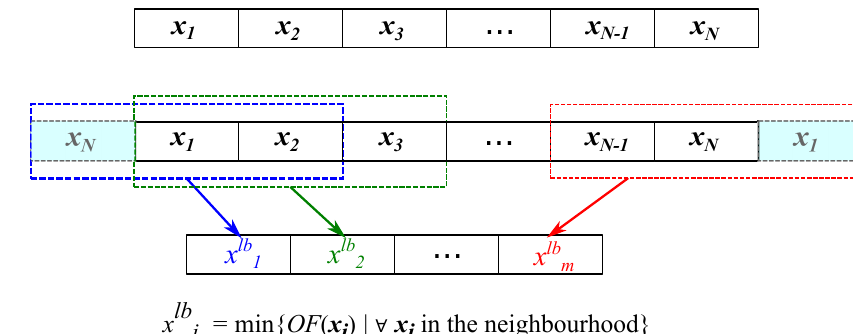
Figure 2. Graphical schematization of the Ring topology implementation ( R =